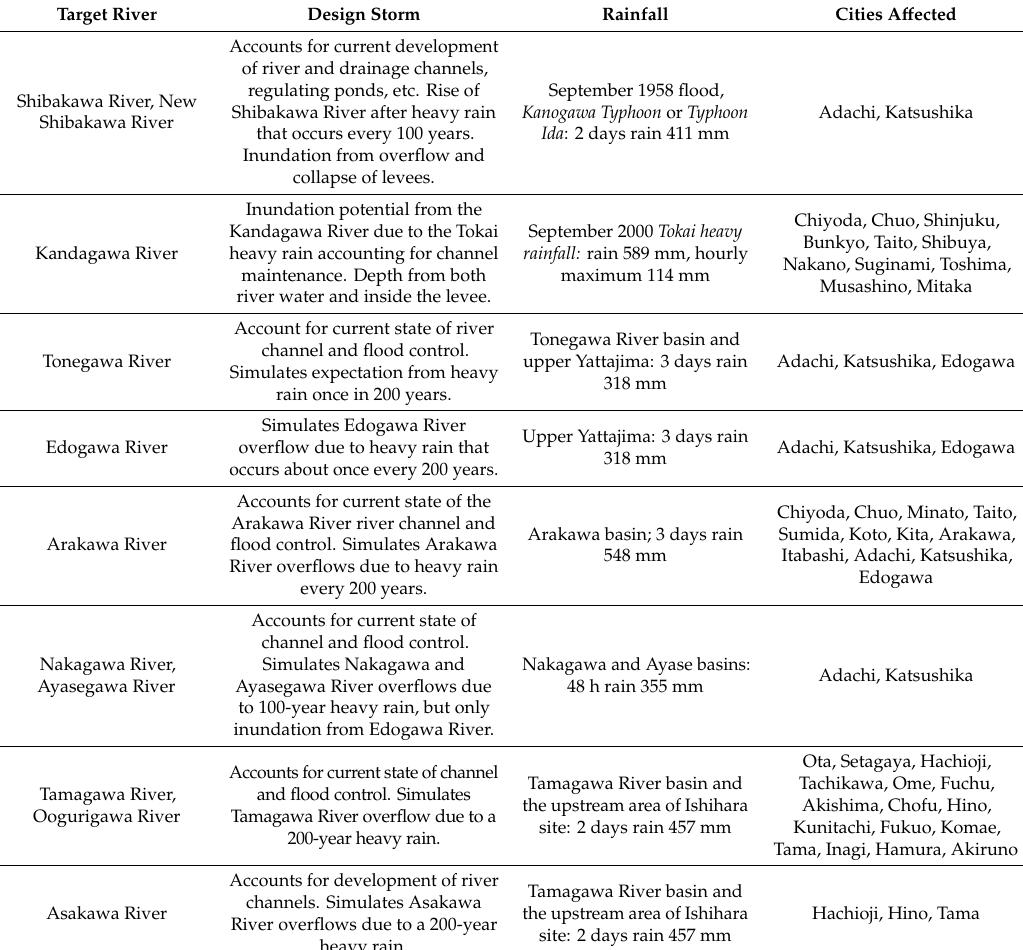
Table 1. Design storms (i.e., a hypothetical discrete rainstorm) characterized by a specific duration in each river. Note full details in MLIT 2020.